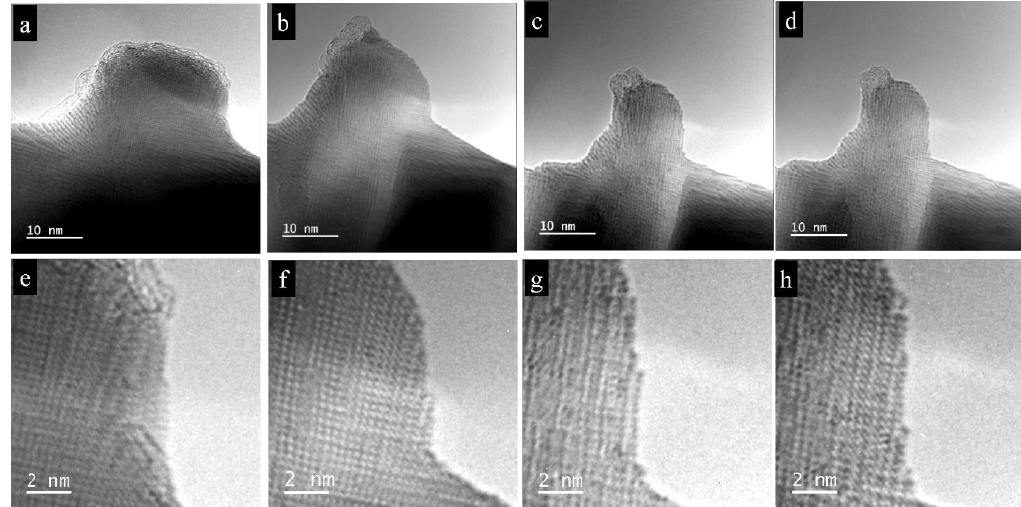
Figure 4. Depletion of the initial single-crystal particle. ( a – d ) Depletion of an integrated nano-bar-like formation along the edge of the initial crystal, leading to a buckling at the final state. The size decreases continuously from 30 nm to about 10 nm. At the top of the bar, curling and fibrillation occurs. ( e – h ) Layer-by-layer depletion of the initial PbTe particle. Further magnification of the snapshot in Figure 4a, recorded during the depletion process, revealed high tension and stress within the sample caused by the high-energy input. The 100 direction within the cube-like convexity (upper red arrow) differed by about 5 degrees from the 100 direction within the matrix below (red arrow at bottom), see Figure 5a. At the top, the outermost atomic rows of the crystal seemed to detach from the surface and tended to form fibril-like structures, see Figure 5b, red arrow. In addition, within the convexity, diversification of the lattice planes occurred (Figure 5c), where the 010 direction showed 10 degrees’ divergence from the inner part (red arrow, left) when moving to the edge (red arrow, right). The layer-by-layer removal of PbTe is nicely seen on the left edge of the convexity, and steps and kinks on the atomic level are clearly pic- tured, follow e.g., red arrows (Figure 5d).